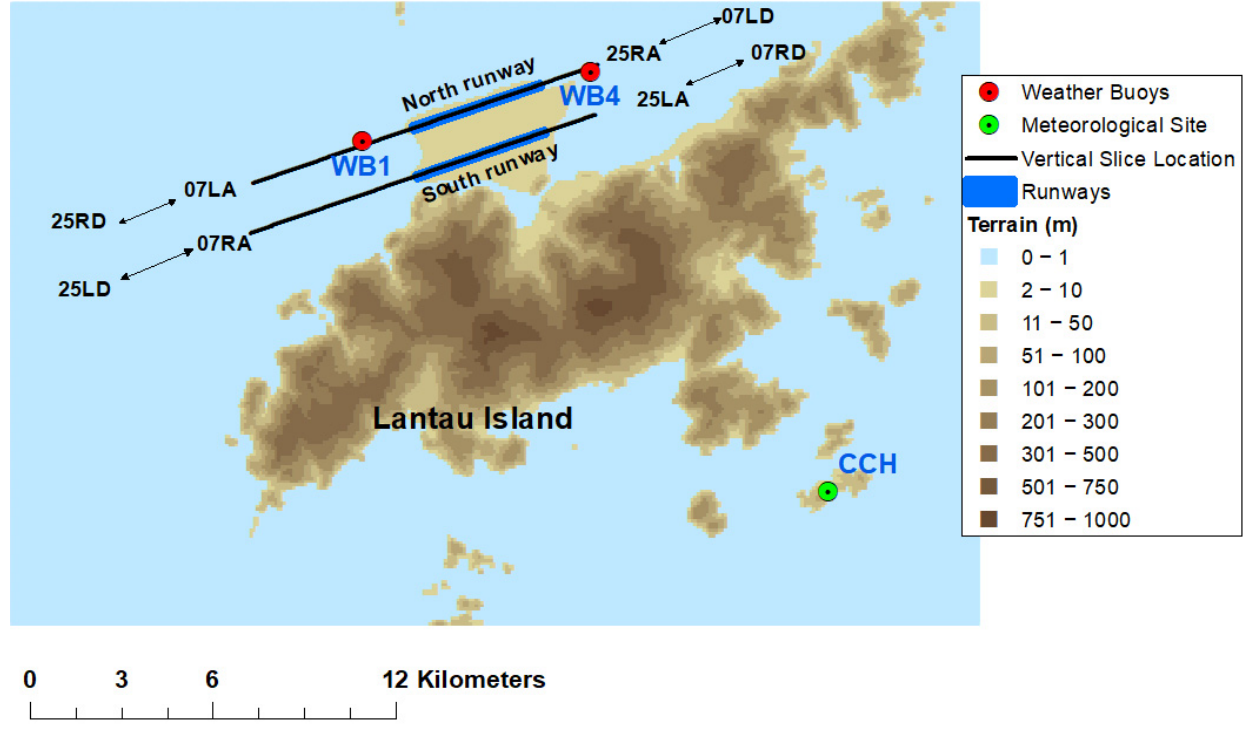
Figure 1. Hong Kong International Airport runways © OpenStreetMap (and) contributors, CC-BY-